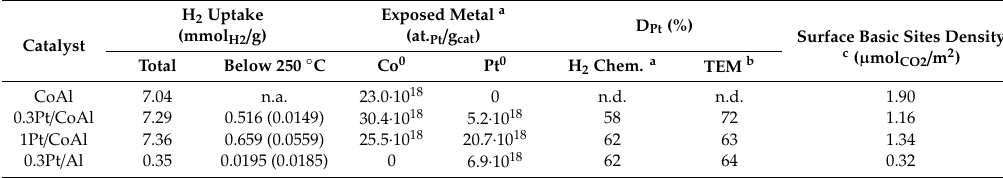
Figure 2. H 2 -TPR profiles of prepared samples. Table 2. Results from H 2 -TPR, H 2 chemisorption and CO 2 -TPD studies.